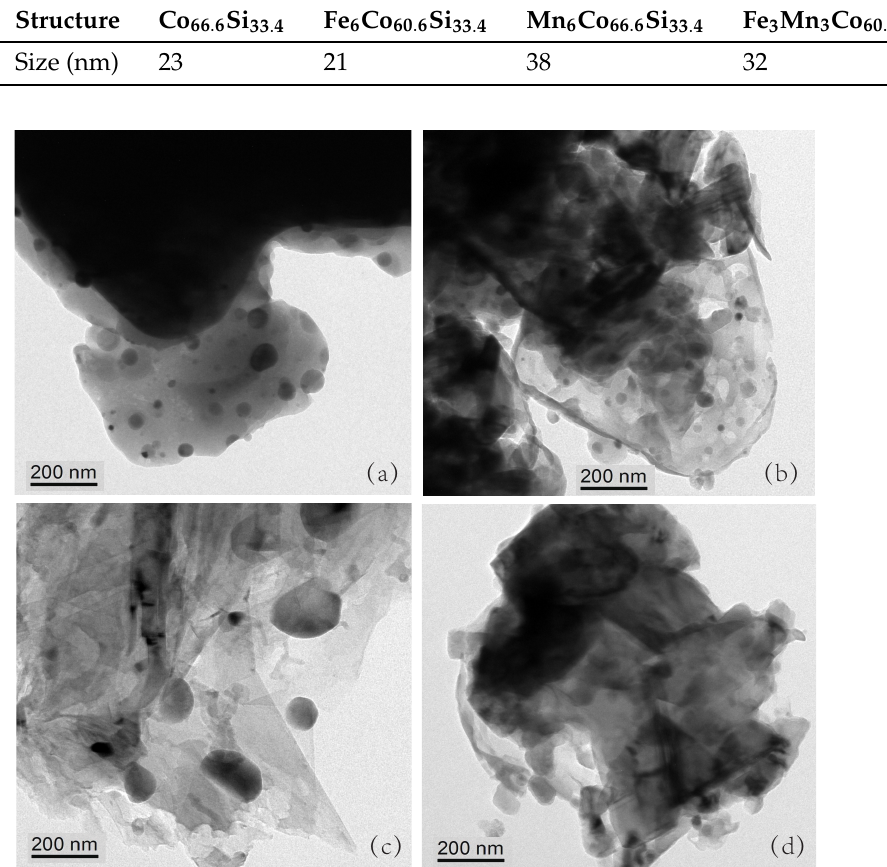
Figure 3. ( a – d ) Powder micrograph images of Co 66.6 Si 33.4 , Co 60.6 X 6 Si 33.4 , (X = Fe, Mn), and Co 60.6 Fe 3 Mn 3 Si 33.4